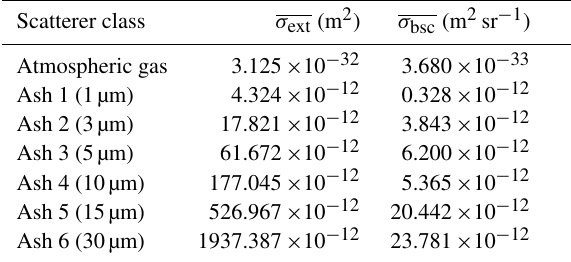
Table 3. Effective optical cross sections of atmospheric gas molecules and six volcanic ash size calculated for the ACL wave- length ( λ = 1064nm). While the effective extinction cross section increases nearly exponentially with the particle size, the effective backscatter cross section does not even scale linearly with the par- ticle size. Consequently, the ACL-measured attenuated backscatter coefficient is less sensitive to number density variations of size class 6 than those of size class